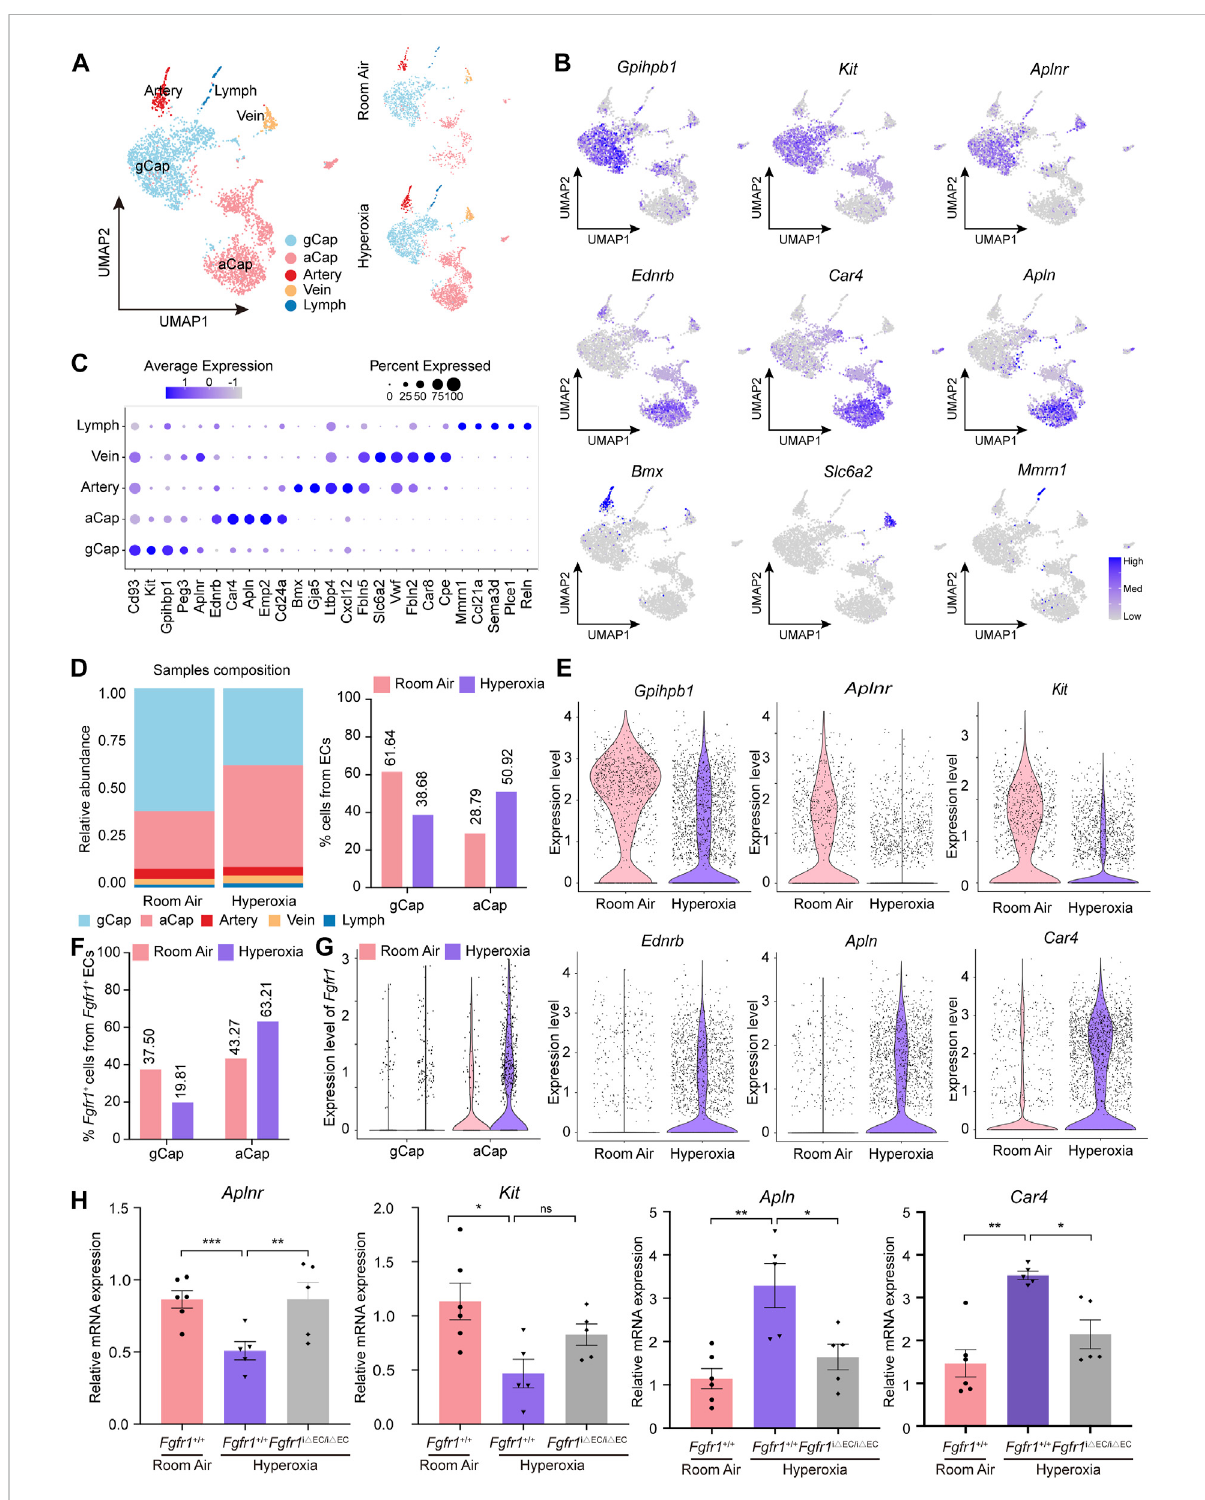
Hyperoxia induced upregulation of FGFR1 mainly in aCap cells rather than in gCap cells. (A) A total of 5 clusters of ECs were identi fi ed. Cell populations are colored as indicated by the legend. (B) Feature plots showing the expression of principal identi fi ers of general capillary endothelial cells (gCap), aerocyte capillary endothelial cells (aCap), arterial endothelial cells (Artery), venous endothelial cells (Vein) and lymphatic endothelial cells (Lymph). (C) Dotplot depicting the top 5 most differentially expressed genes across endothelial clusters. The intensity of expression